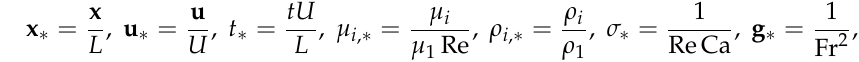
Figure 8. Convergence test for the vortex problem. The error E = penalization coefficient η at time t = 0.3 and Reynolds number Re = 30. Here, u velocity field given in Equation (28), and u 0 = exp given for different adaptation thresholds log refinement is set to J max = 13, and the current level of refinement satisfies J < J max